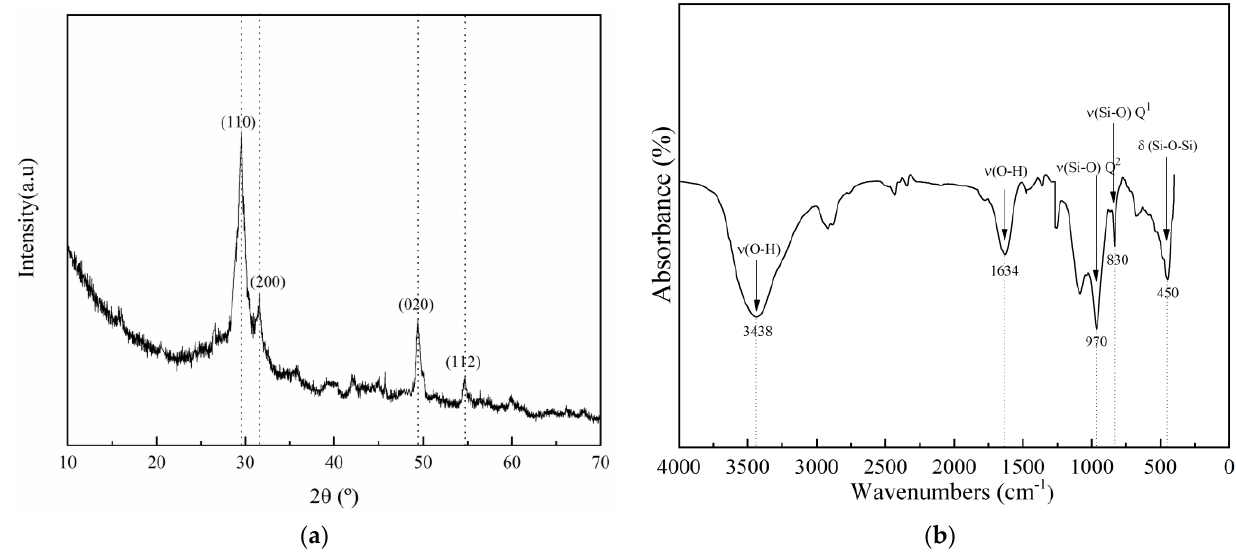
Figure 1. XRD ( a ) and infrared spectrum ( b ) of CNA.